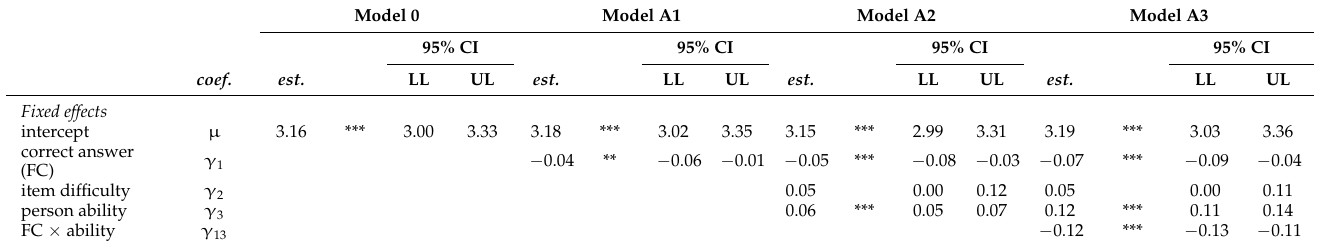
Table 1. Parameters of the models assessing the F > C phenomenon (interacting with a person’s